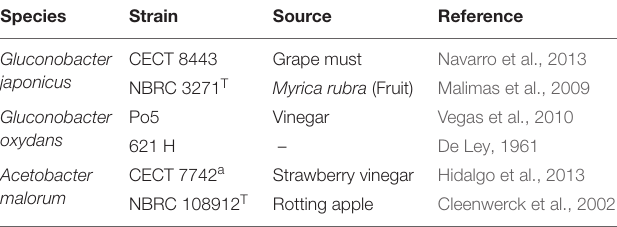
TABLE 1 | Strains used in this